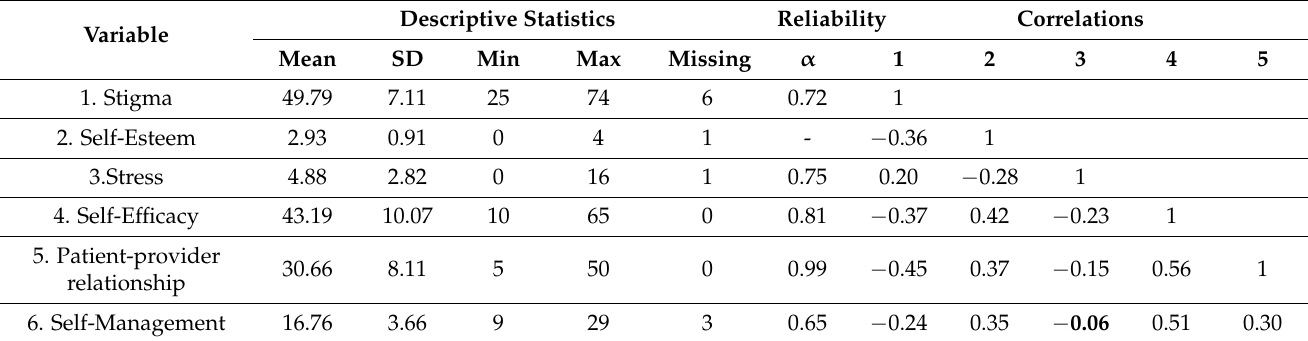
Table 2. General analysis for psychosocial and self-management variables.